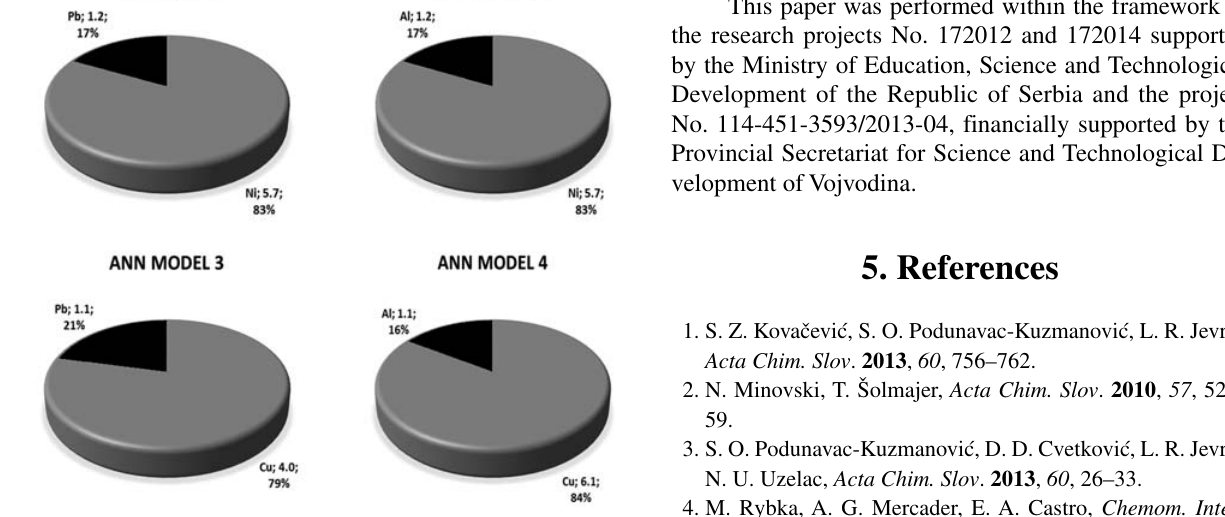
Figure 2. The GSA coefficients of the input